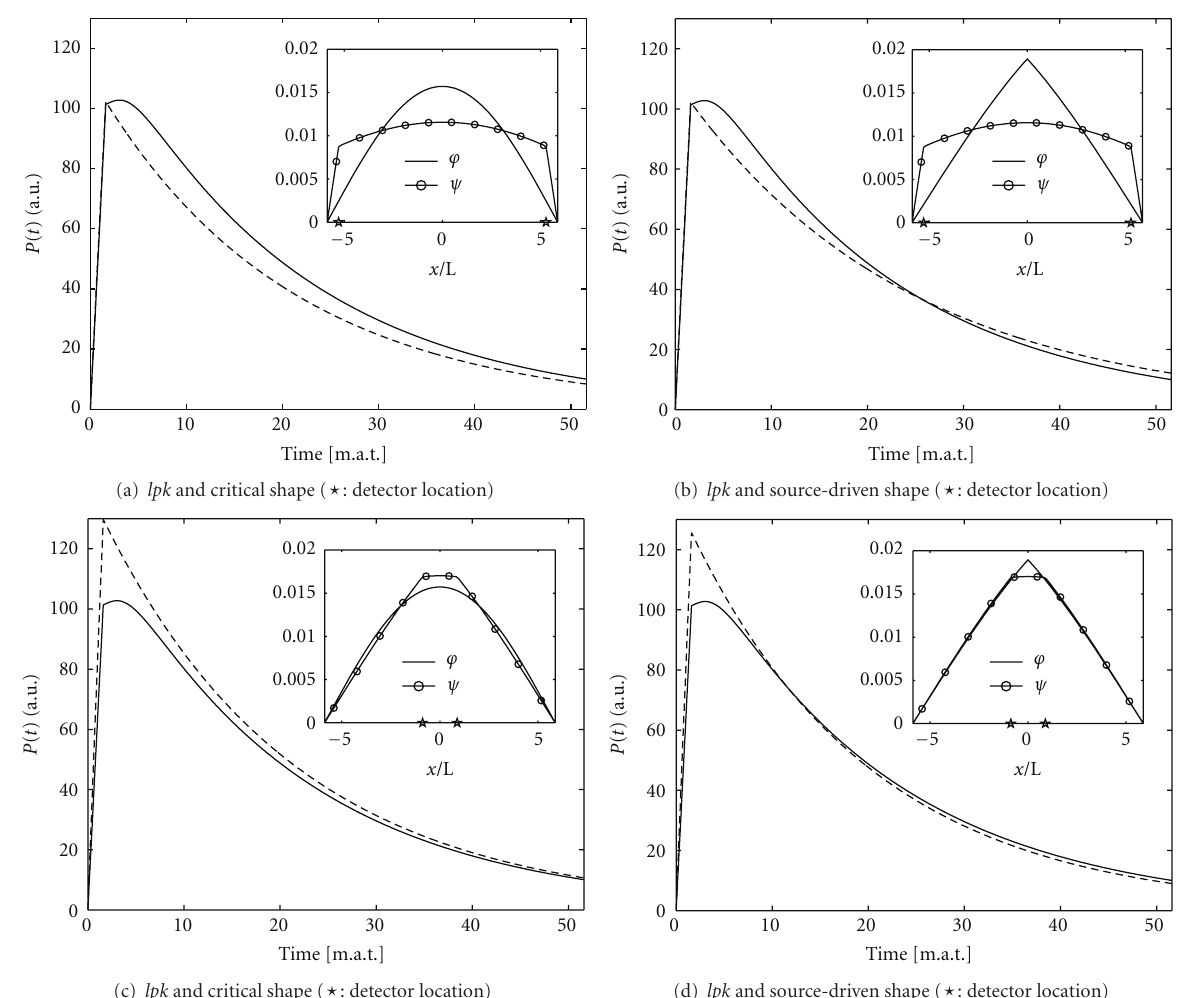
Figure 2: Power evolution following a source pulse in a subcritical system (k e ff = 0 . 95), simulated with a lpk approach, considering two di ff erent detector locations: first row, detector far from the source ( x 0 = 5 . 3L); second row: detector close to the source ( x 0 = 0 . 9L). Solid line: reference; dashed line: point kinetics. The inset graphs represent the shape ϕ and the weight ψ